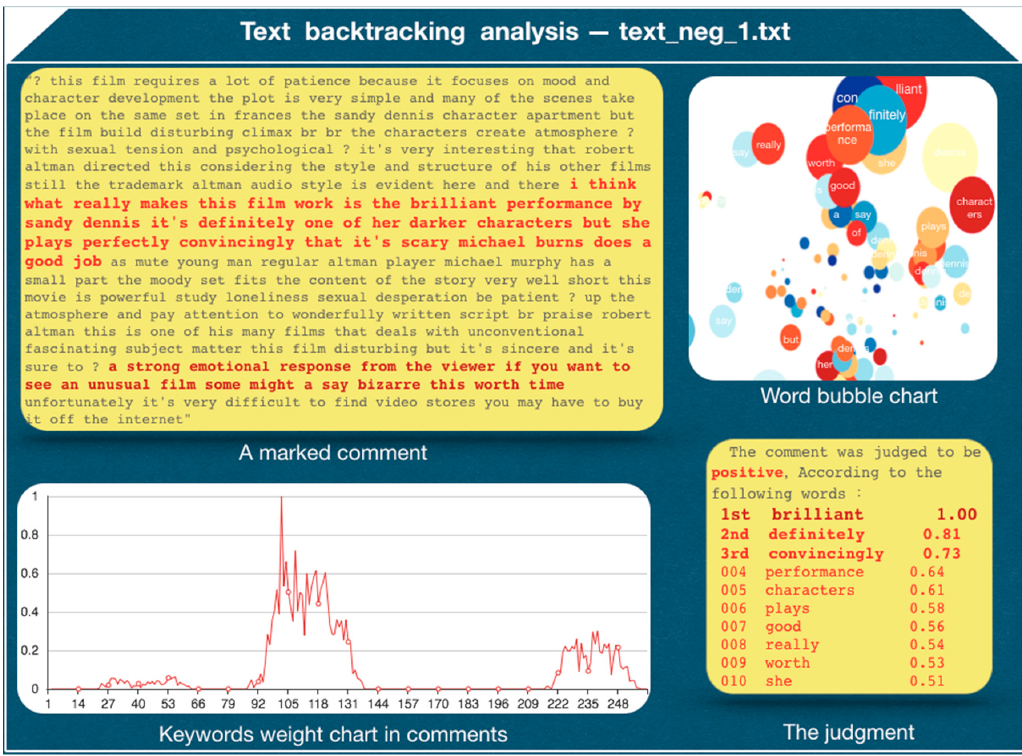
Figure 13. Detailed analysis of IMDB comments.